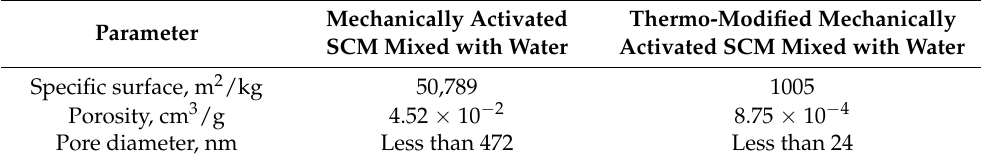
Table 2. SCM specific surface area, porosity, and pore size.